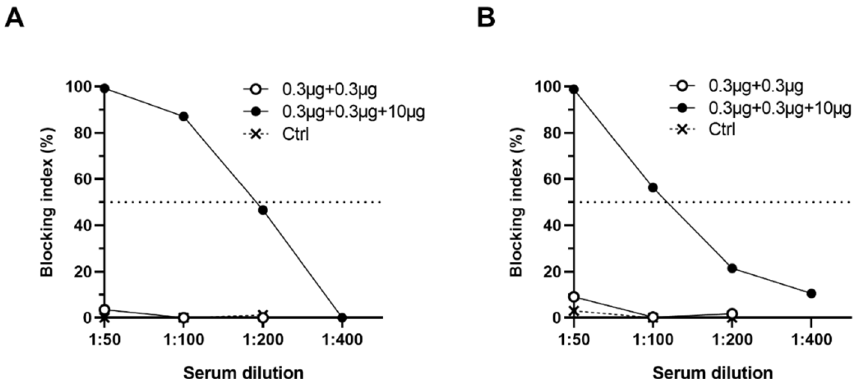
Figure 5. Blocking of norovirus (NoV) VLP binding to histo-blood group antigens (HBGAs). Two- fold diluted, group-wise pooled sera of mice immunized with 0.3 µg NoV GI.4 and GII.4-2006a VLPs alone, or mixed with 10 µg VP6, and the control (Ctrl) mice sera were tested for potential to block binding of NoV ( A ) GI.4 or ( B ) GII.4-2006a VLPs to HBGAs present in pig gastric mucin (PGM). Shown are group mean blocking index (%) with standard error of the mean. Horizontal dashed line represents 50% blocking.